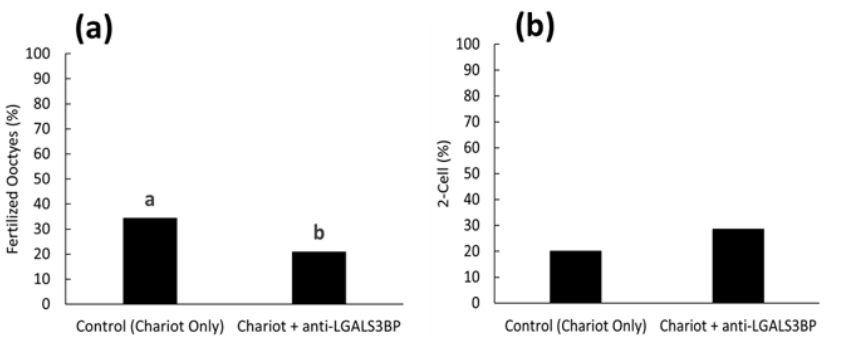
Figure 10. Proportions of ( a ) fertilized oocytes and ( b ) 2-cell embryos 17 h after insemination with caput spermatozoa previously treated with EVs transfected with Chariot reagent alone (control Chariot only) or with Chariot-transfected EVs with anti-LGALS3BP (Chariot + anti-LGALS3BP). Bars with different letters significantly differ ( p < 0.05).